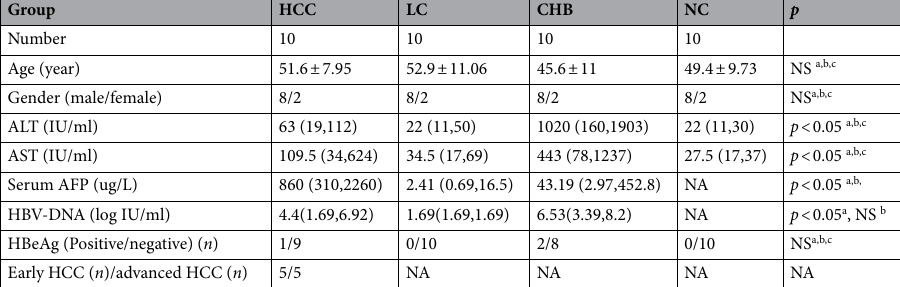
Table 1. Demographic and clinical characteristics of the discovery cohort. The quantitative variables of the normal distribution were represented as mean ± standard deviation (SD), the student’s-t test was used for comparison between the two groups, and analysis of variance was used for comparison between multiple groups. The quantitative variables of the non-normal distribution were represented by median (range), the Mann–Whitney U test was used between two groups. a HCC group versus LC group; b HCC group vserus CHB group; c HCC group versus NC group. Abbreviations: NC normal control, CHB chronic hepatitis B, LC liver